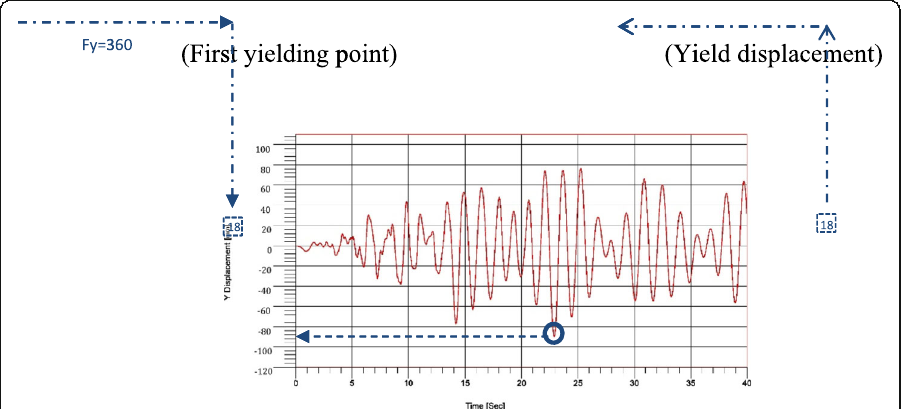
Fig. 21 Top roof displacement time history (maximum displacement)